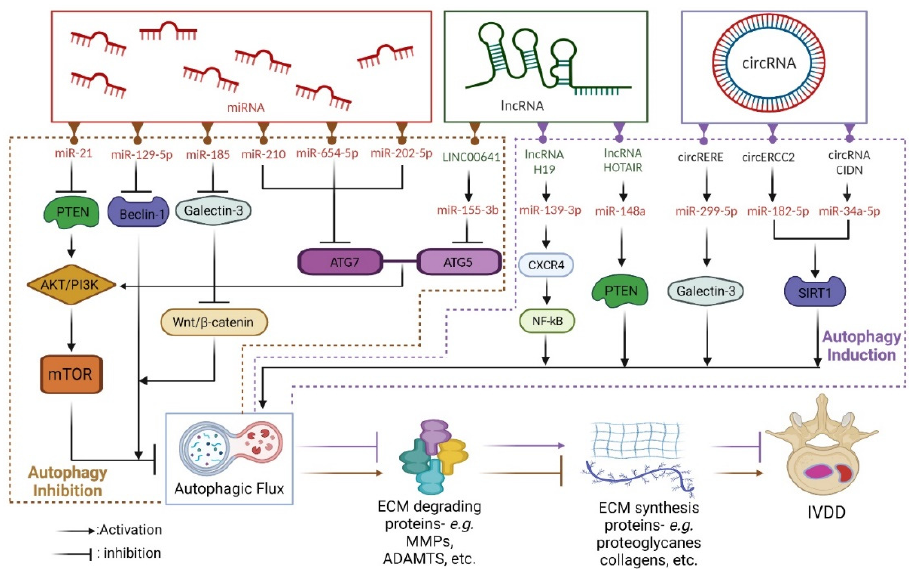
Figure 4. Autophagy-targeting ncRNAs for the treatment of IVDD. ncRNAs including miRNA, lncRNA, and circRNA could play important roles in IVDD treatment. These molecules can either activate (purple dotted box) or inhibit (brown dotted box) the autophagic flux, resulting in less degradation of ECM synthesis genes in IVDD.